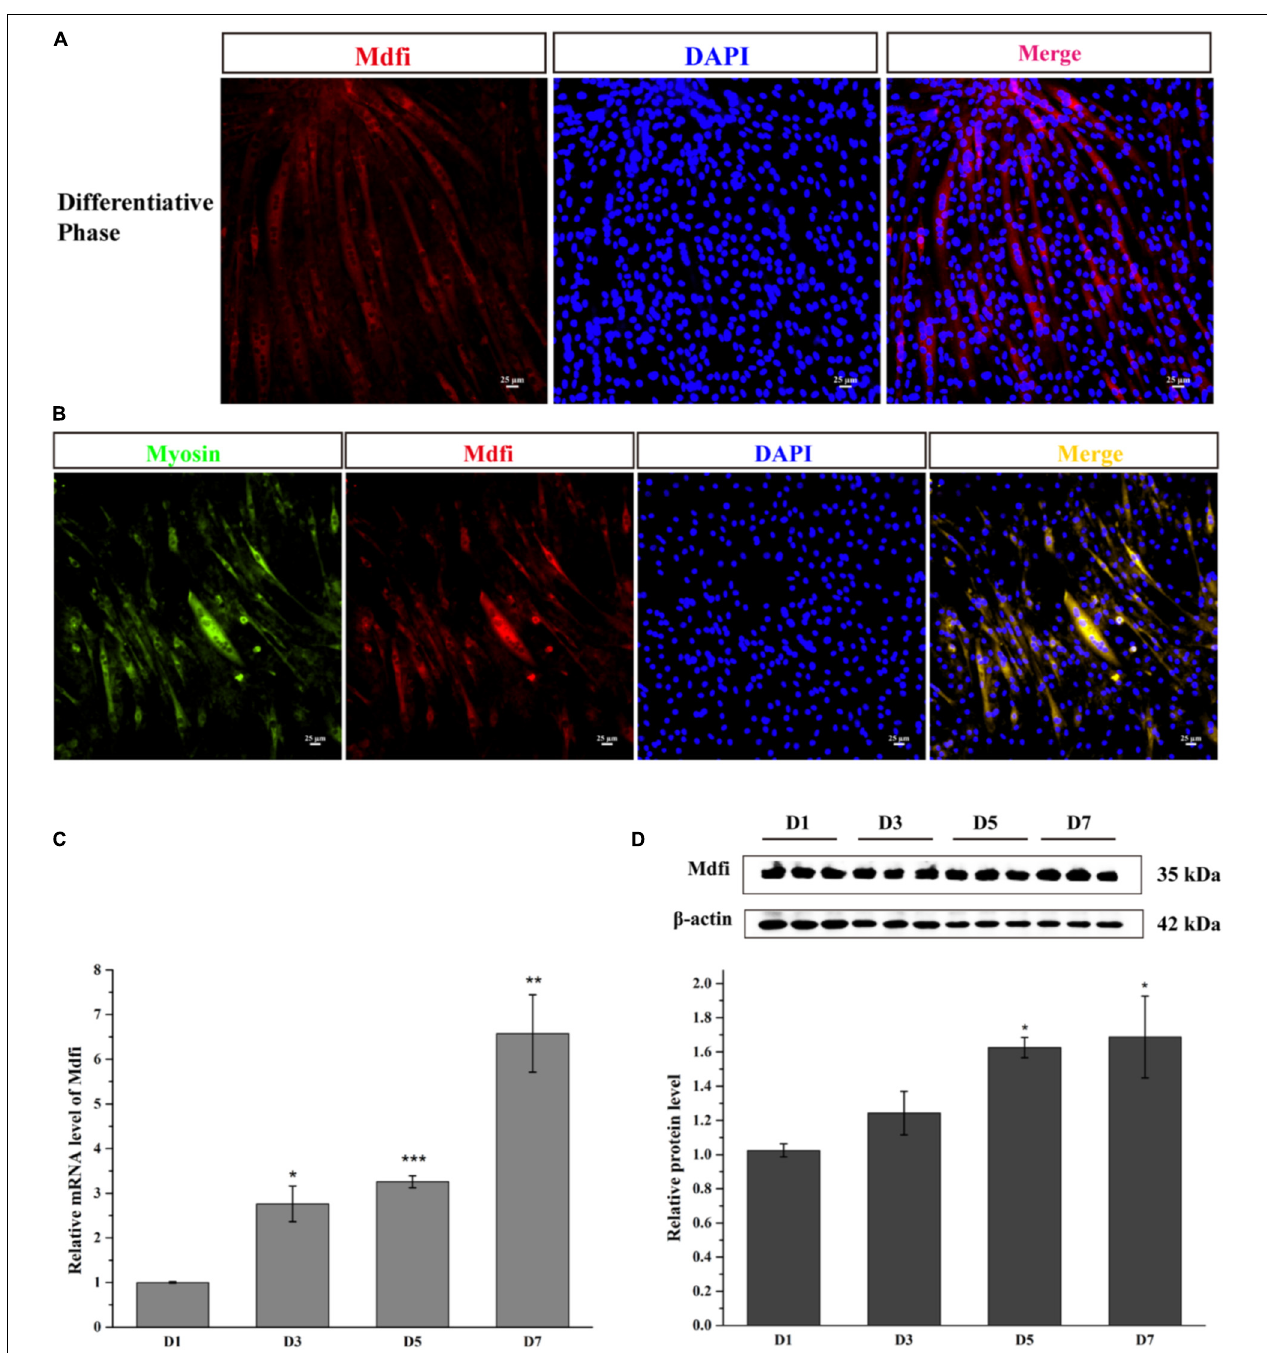
FIGURE 1 | Mdfi-expression profile during C2C12 cell development. (A) Mdfi immunofluorescence of C2C12 cells in differentiative phase. (B) Mdfi and myosin co-immunofluorescence of C2C12 cells in differentiative phase. Myosin: green, a molecular marker of myogenesis; Mdfi: red; DAPI: blue, cell nuclei; Merge: C2C12 cells fused into multi-nucleic myotubes. (C) qPCR identified Mdfi mRNA level on days 1, 3, 5, and 7 after differentiation induction. (D) Western blot identified Mdfi protein level on days 1, 3, 5, and 7 after differentiation induction. * p < 0.05; ** p < 0.01; *** p < 0.001. The results are presented as Mean ± SEM of three replicates for each group. Magnification 200 × . The scale bar on the photomicrographs represents 25 µ m.